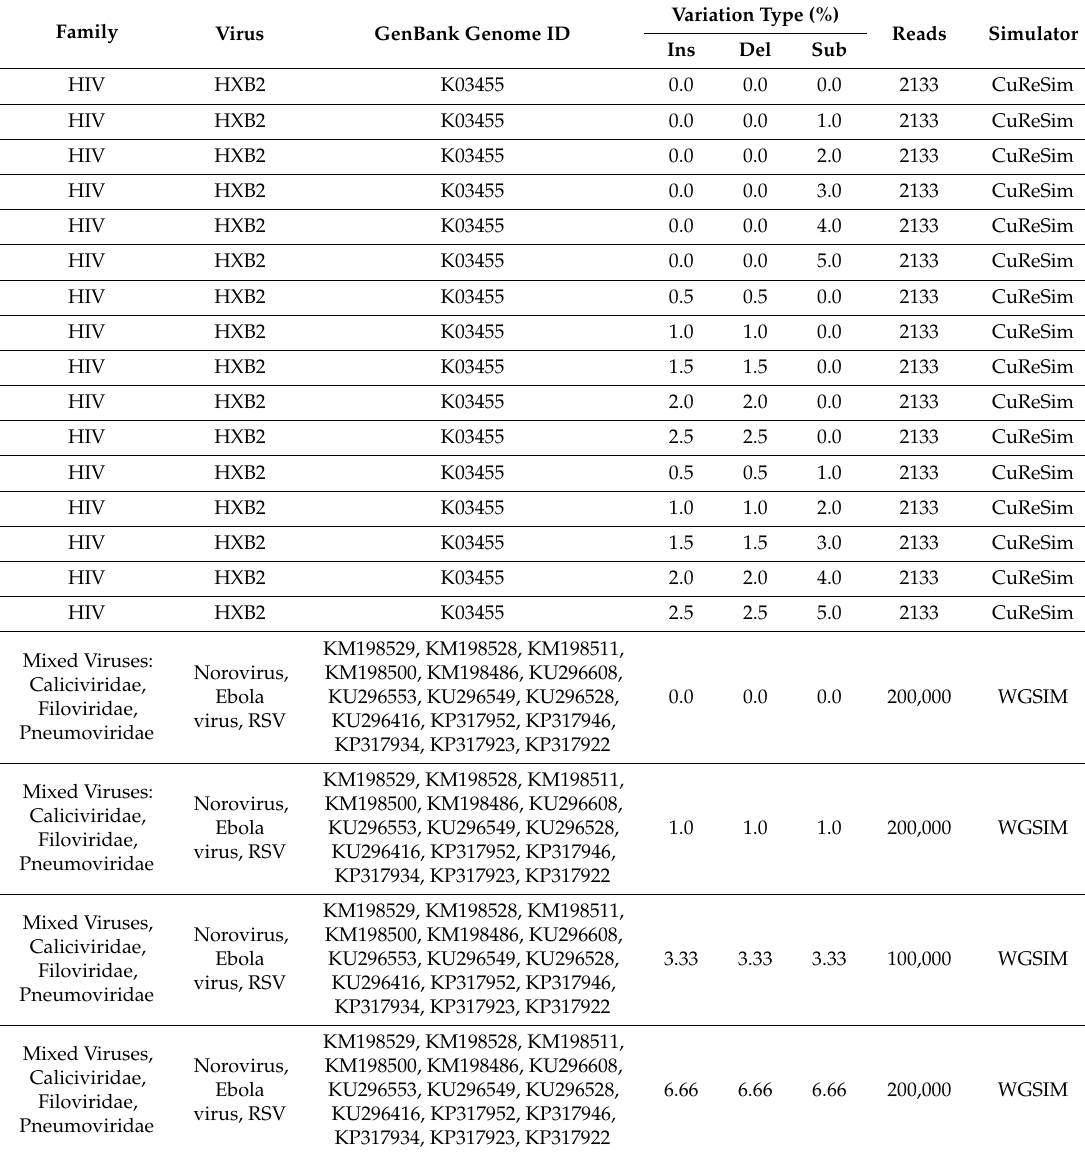
Table 2. Simulated read data. Each row contains details for each simulated dataset (i.e., virus family, virus, GenBank ID, variation type, variation level, number of reads and simulator used to generate data). Abbreviations: Ins, insertions; Del, deletions and Sub,